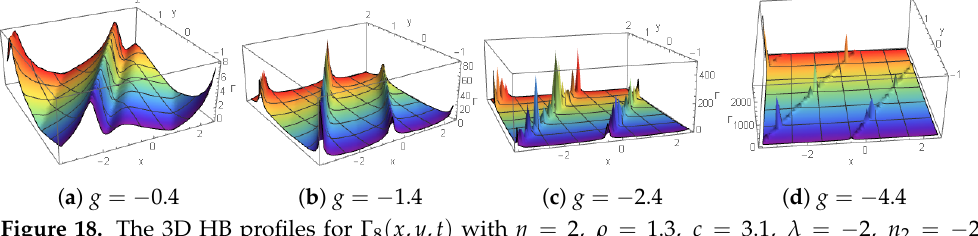
Figure 18. The 3D HB profiles for Γ 8 ( x , y , t ) with η = 2, ρ = 1.3, c = 3.1, λ = − 2, n 2 = − 2, n 6 = 3, m 2 = − 1, m 1 = 2, m 4 = 3, g 1 = − 5, and t =